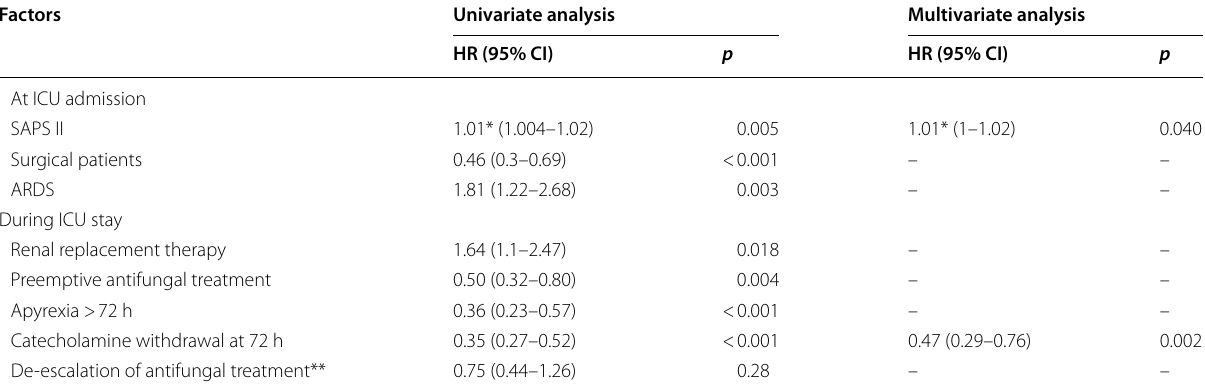
Table 4 Factors associated with ICU mortality by Cox proportional hazards